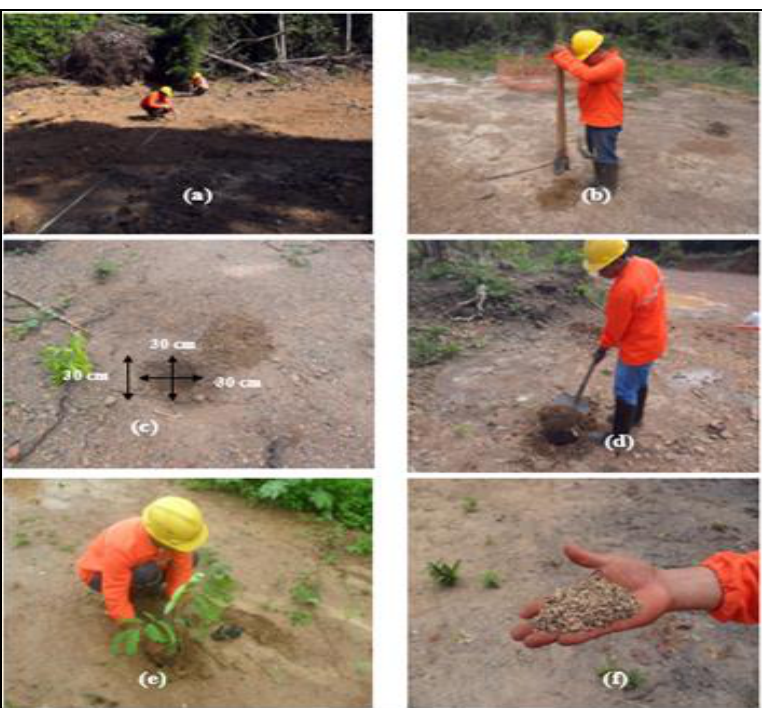
Figure 3: (a) Team contributors Environmental doing the measurement and the piqueteamento the area to be recovered; (b) Employee performing the rutting later manually to piqueteamento; (c) Exemplification dimensioning of the grooves made in the recovered area; (d) Application of organic fertilizer in scaled groove; (e) Planting of native species paricá ( Schizolobium amazonicum ); (f) Braquiarão seeds (Urochloa brizantha) used in the recovery of impacted areas, establishing the SAF type agrosilvicultural. Source: